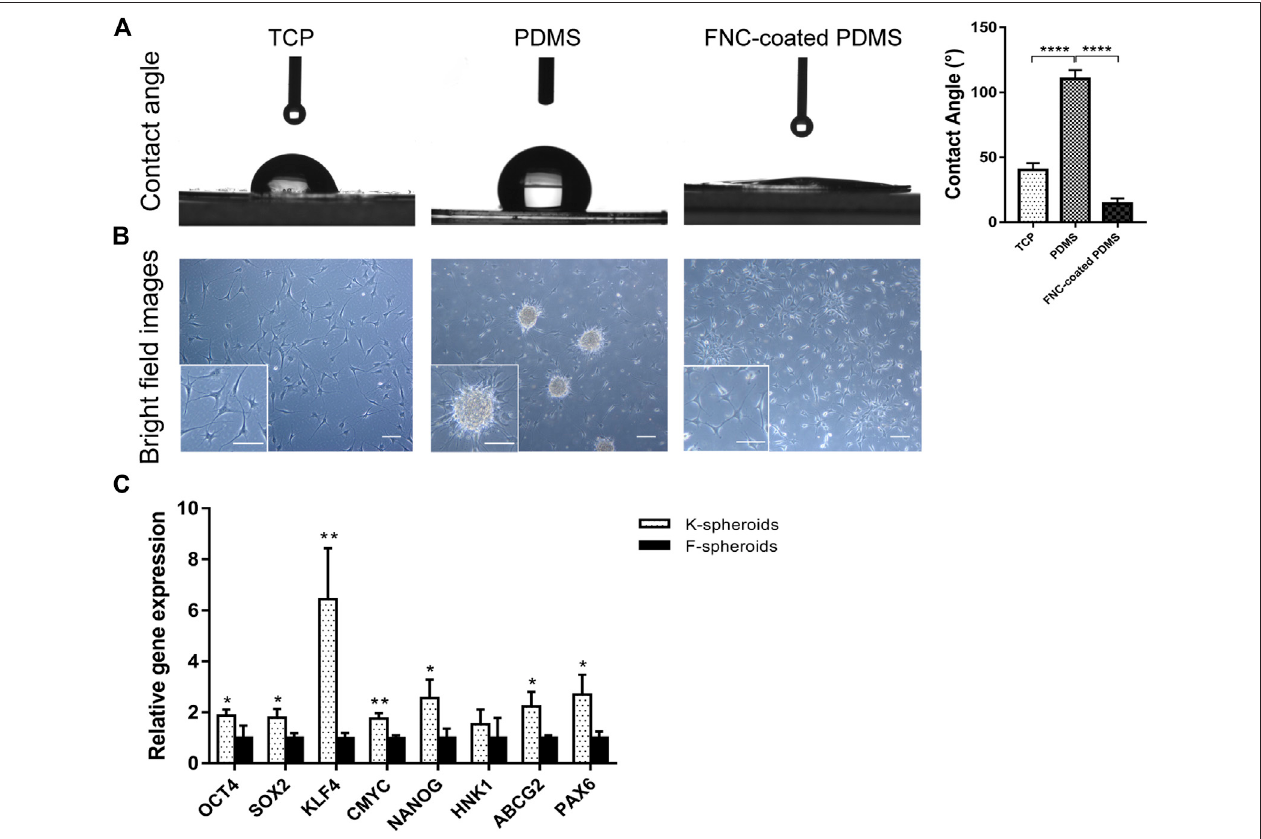
FIGURE 2 | Characteristics of different spheroids and contact angles on TCPs, PDMS and FNC-coated PDMS. (A) The contact angle of PDMS was signi fi cantly higher than that of TCPs and FNC-coated PDMS. (B) Light microscopy revealed that keratocytes spontaneously formed spheroids on PDMS. The cells adherent to TCPsandFNC-coatedPDMSwithoutformingspheroidsexhibiteddendriticorstellateshapes,andcellprocessesextendedtoconnectwithneighboringcells. (C) qPCR analysis indicated that stemness transcription factors ( OCT4 , NANOG , SOX2 , KLF4 and CMYC ) and corneal stem cell markers ( ABCG2 and PAX6 ) were signi fi cantly higher in keratocyte spheroids (K-spheroids) than in fi broblast spheroids (F-spheroids). (* p < 0.05; ** p < 0.01; *** p < 0.001; **** p < 0.0001). Scale bars: 100 μ